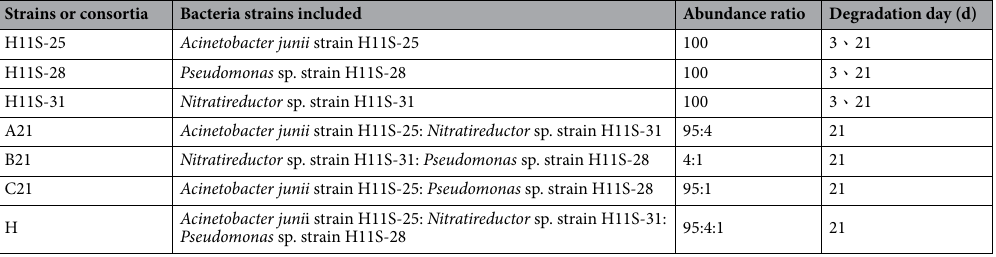
Table 2. The scheme of strain abundance ratio in constructed consortia.